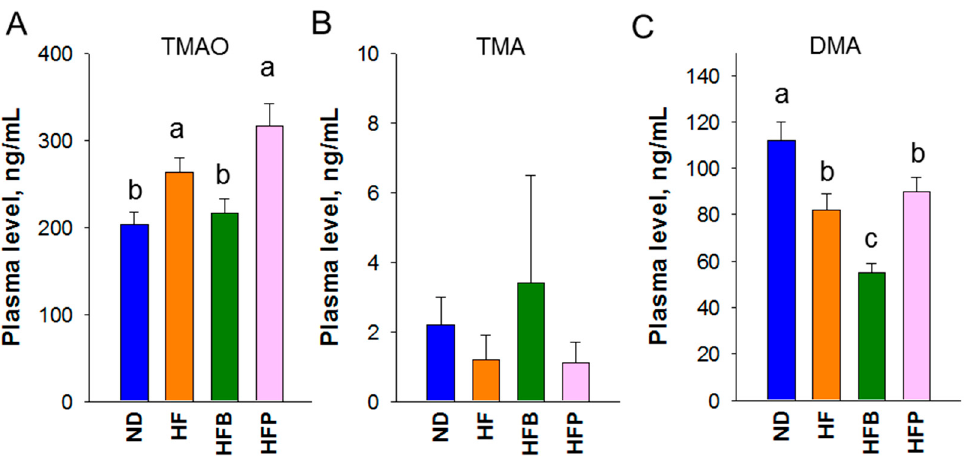
Figure 3. Plasma concentrations of ( A ) trimethylamine-N-oxide (TMAO), ( B ) trimethylamine (TMA),